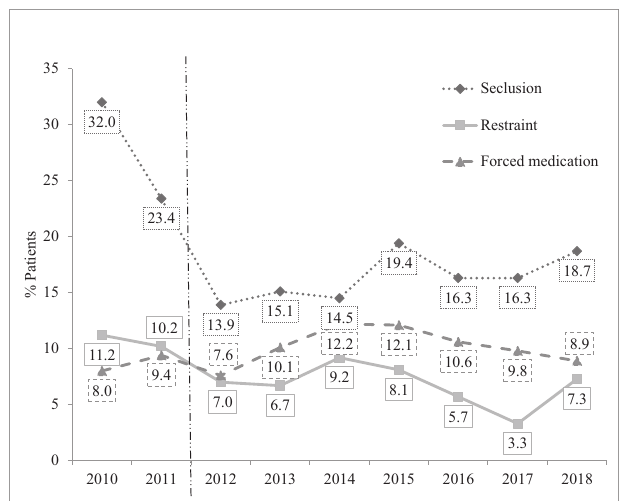
FIGURE 1 | Percentage of patients subjected to at least one incident of coercive measure (relative to the total patient population). The dotted vertical line represents the policy